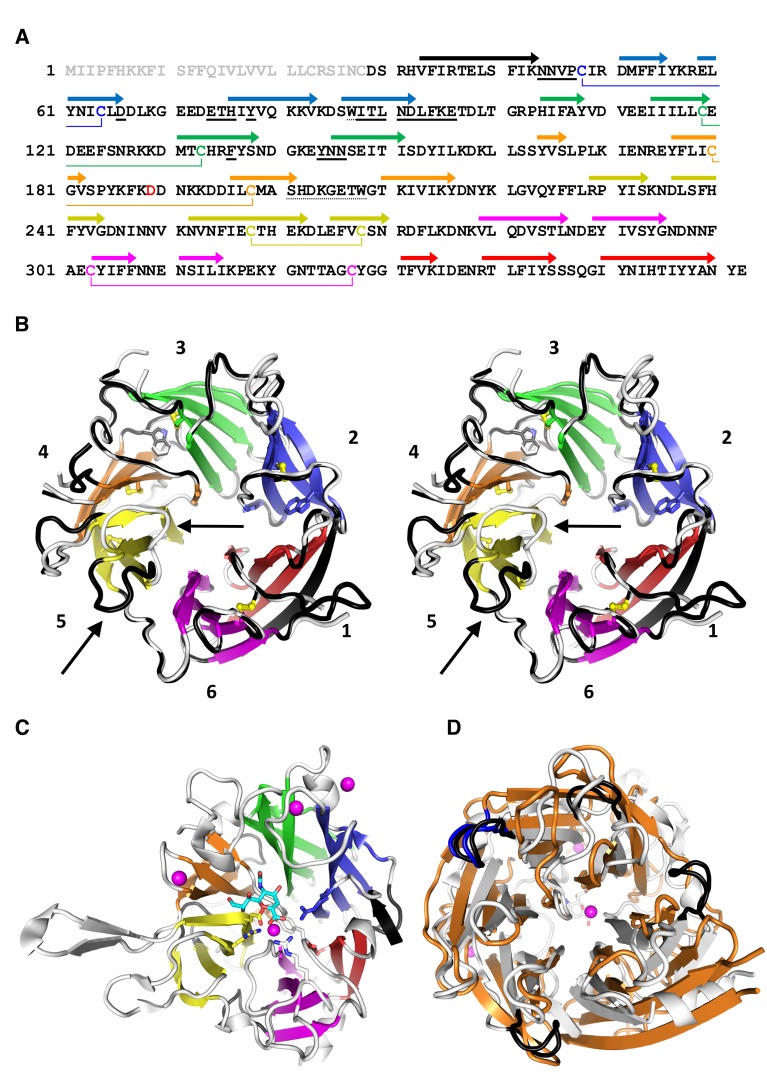
PfCyRPA adopts the neuraminidase fold.(A) Structure-sequence relationship of PfCyRPA. Indicated are an Actinase E cleavage site at Asp189 (red), a sialidase-typical Asp-box (dotted underlined), the two Trp residues (dotted underlined), and the sequential disulfide bonds (connected by lines and in same color). β-strands are shown as arrows colored according to the blade they form. The epitope recognized by mAb c12 is underlined in bold. (B) Cross-eyed stereo view of the ribbon representation of a superposition of the two PfCyRPA molecules in the asymmetric unit with the blades numbered 1–6 from the N-terminus and colored individually. Blade one is made up of an N-terminal (black) and three C-terminal β-strands (red). One protomer is shown with white, the other with black loop regions, which may differ substantially (arrows in blade 5). The Trp and Cys residues are drawn as stick models. (C) The same orientation of the catalytic domain of Vibrio cholerae sialidase (PDB-ID 1w0o), the next structural homolog of PfCyRPA with a DALI score of 18 (Z < 5 is structurally dissimilar). Sialic acid and residues in the Vibrio enzyme are displayed as balls and sticks. Structural Ca2+ ions are marked as magenta spheres. None of the residues necessary for metal ion binding, substrate binding, or catalysis is present in PfCyRPA. (D) Superposition of PfCyRPA with the V. cholerae sialidase. While both proteins are 6-bladed β-propellers, the blades have very different angles, extents, and loop lengths and conformations connecting the β-strands. The four Asp-boxes in the bacterial sialidase (grey) are colored black. PfCyRPA (orange) has only a single Asp-box connecting the third and fourth β-strands in blade 3 (colored blue). Other β-strand connections are made by sequences unrelated to the Asp-box motif, in agreement with poor conservation of the Asp-box in other, e.g. viral, sialidases. The view in (D) is rotated by 180° about the horizontal axis compared to (B) and (C).